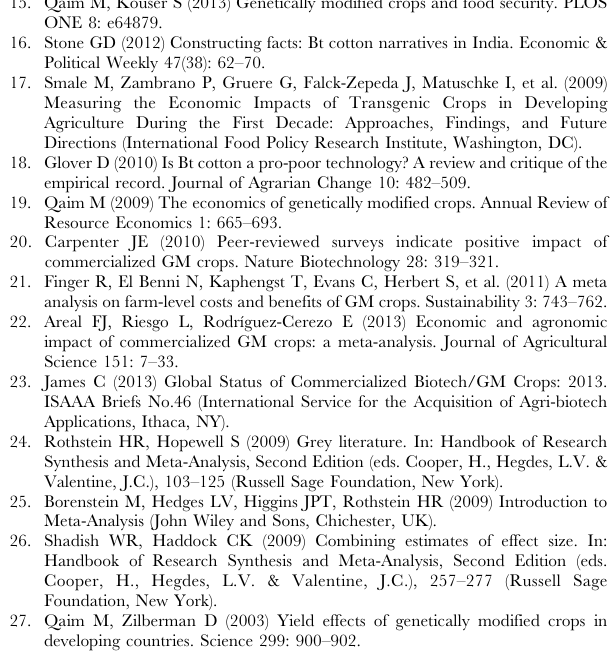
Table S2 Distribution of study descriptor dummy variables for different outcomes. Table S3 Weighted mean impacts of GM crop